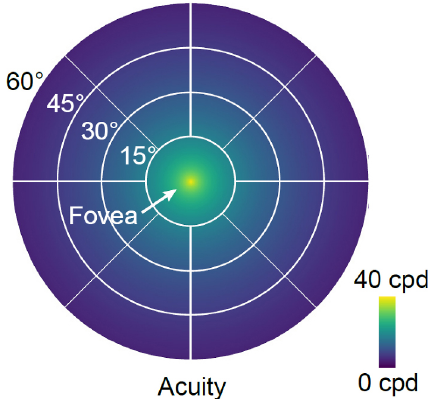
Fig. 2 Visual acuity fall-off model proposed by Geisler and Perry [51]. The HVS visual acuity is the largest (40 cpd) when the eccentricity angle is 0 ◦ . With the increase of eccentricity, visual acuity decreases linearly. When the eccentricity angle exceeds 45 ◦ , visual acuity decreases to 0 cpd. “cpd” means cycles per degree. Reproduced with permission from Ref. [52], c (cid:13) ACM